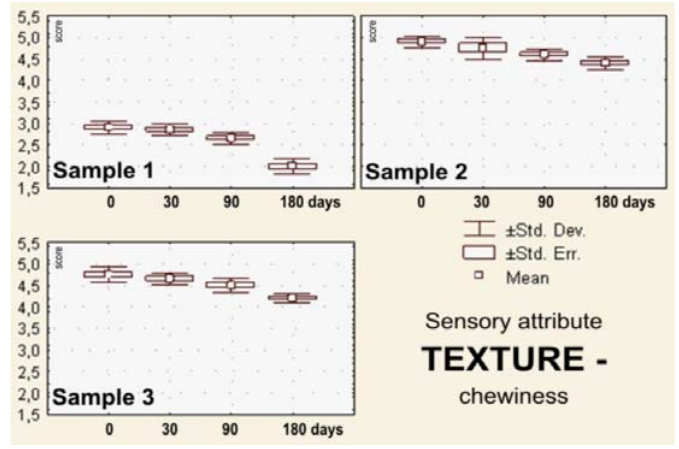
Figure 4. Box-plots for sensory attribute texture —chewiness of the filled pralines (labels as in the Figure 2), during 180 days of